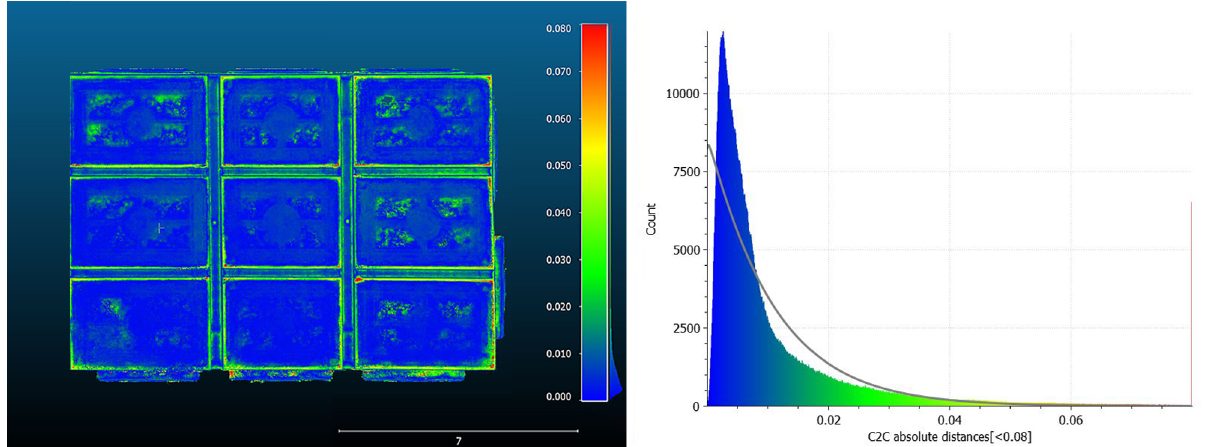
Figure 5 . Comparison between the photogrammetric point cloud of photogrammetric process with Agisoft Metashape (Insta360 ONE R) with respect to laser scanning (Leica HDS7000).